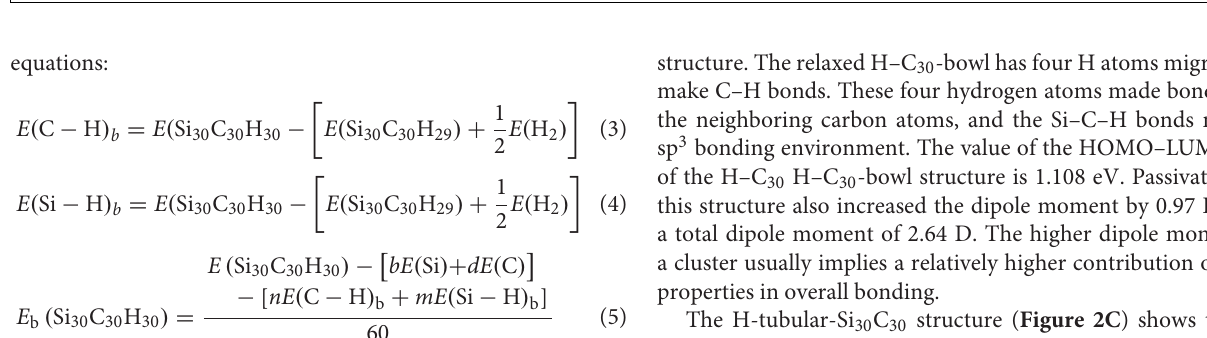
FIGURE 6 | (A) Initial configuration of fullerene with a left bowl of carbon (C 30 ) and a right bowl of silicon (Si 30 ) with 5-Å distance between them. (B) The structure after geometry relaxation. This configuration is similar to Figure 1A . However, the carbon side looks more distorted due to the different initial